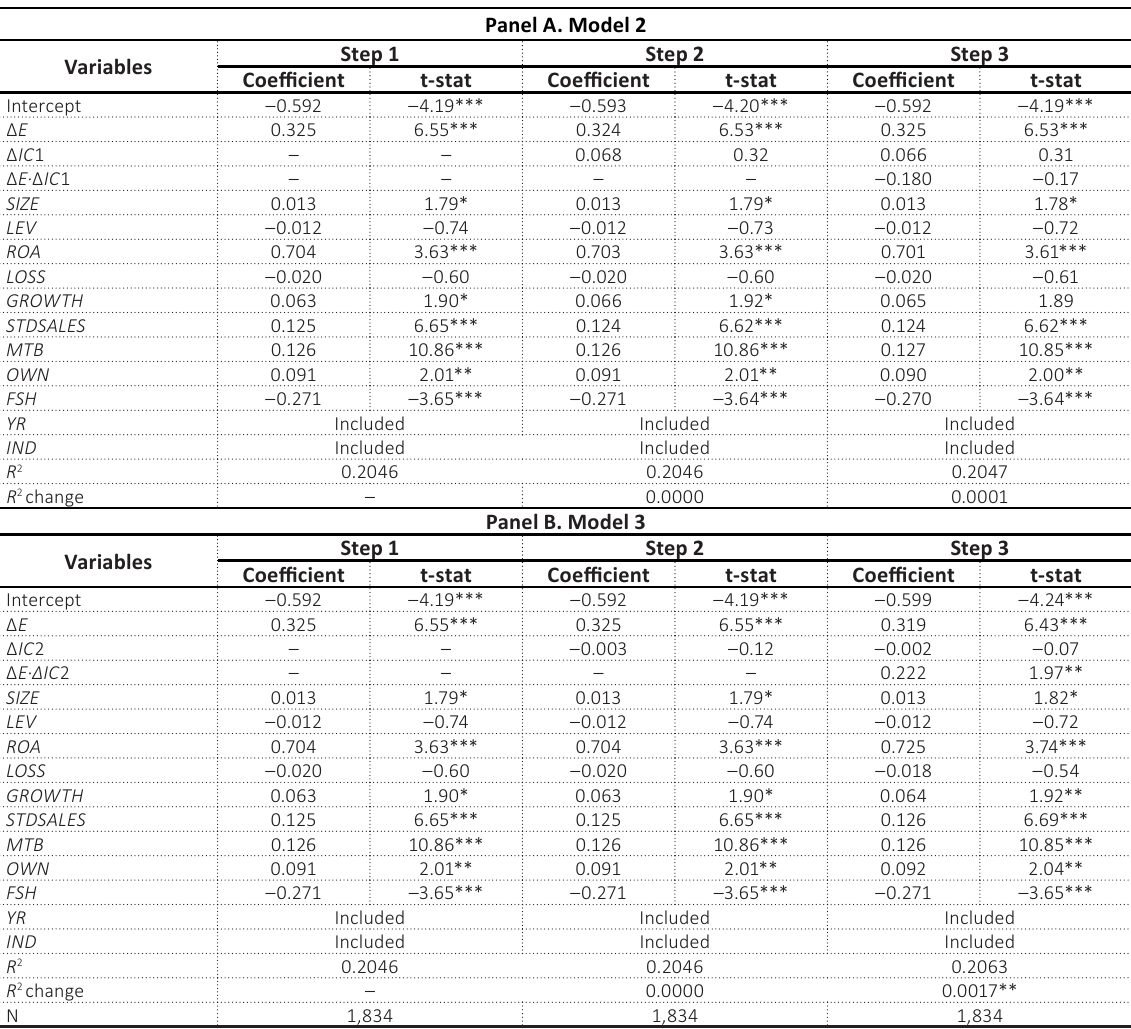
Table 5. Analysis on the effect of IC environment on the value relevance of